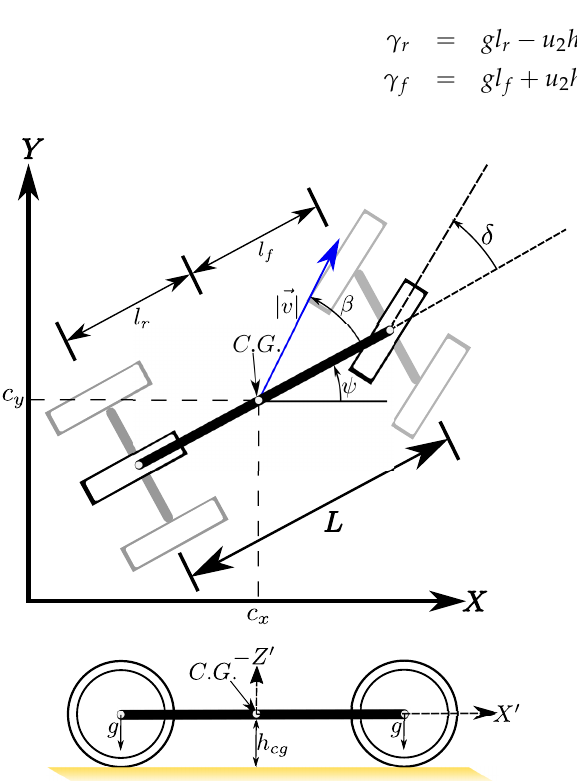
Figure 4. Reference framework for the ST vehicle model.